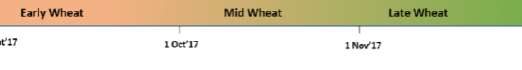
Figure2. Wheat sub classes to account for staggered sowing